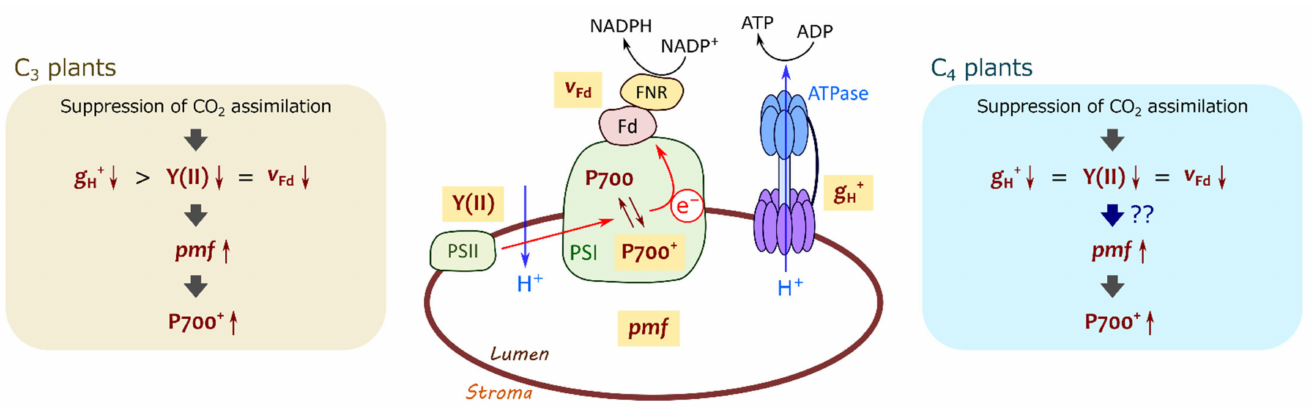
Figure 11. A brief illustration of mechanism for P700 oxidation in C 3 and C 4 plants. In C 3 plants, proton conductance of chloroplast ATP synthase ( g H+ ) decreases with the suppression of photosynthetic CO 2 assimilation greater than pho- tosynthetic linear electron flow reflected in effective quantum yield of PSII, Y(II), and ferredoxin (Fd − ) oxidation rate ( v Fd ), resulting in the increase in proton motive force (pmf) to induce P700 oxidation. In C 4 plants, pmf increases with the suppression of photosynthetic CO 2 assimilation, although g H+ decreases concomitantly with Y(II) and v Fd